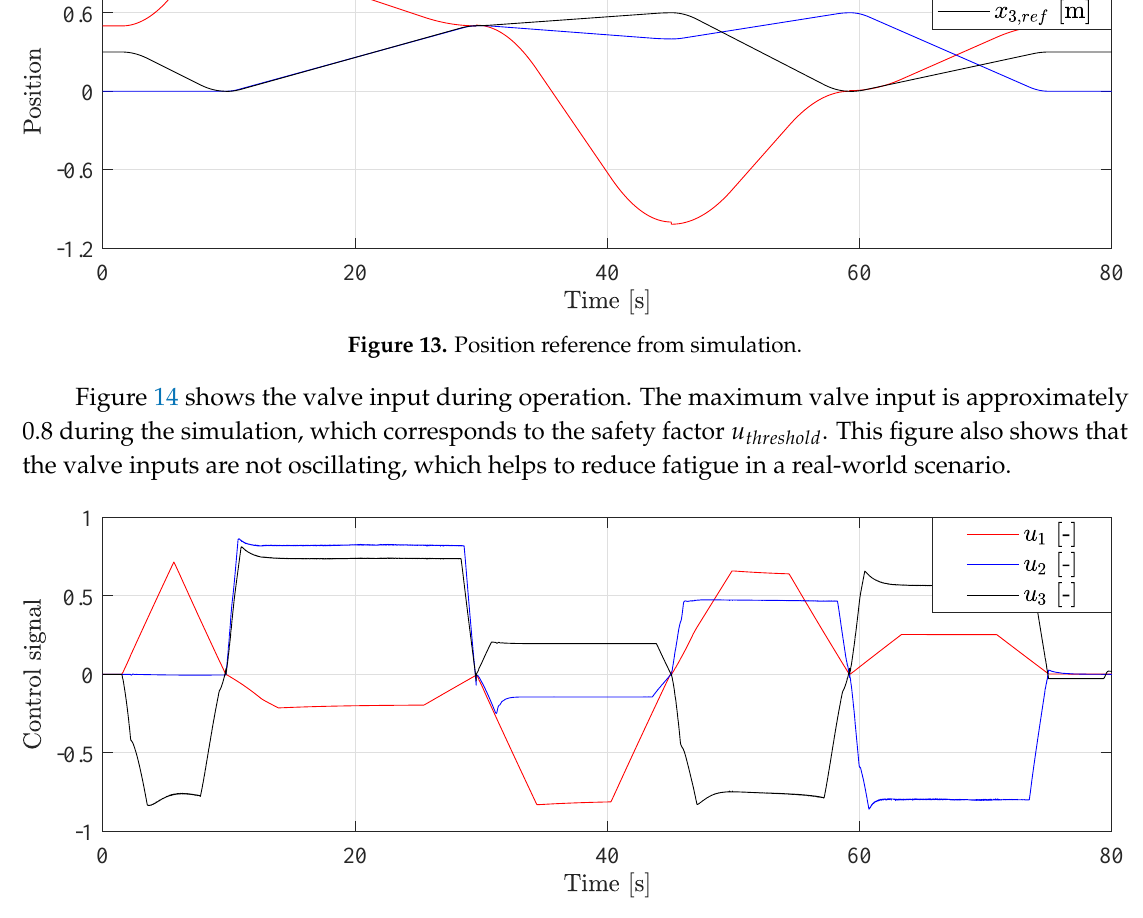
Figure 14. Valve input from